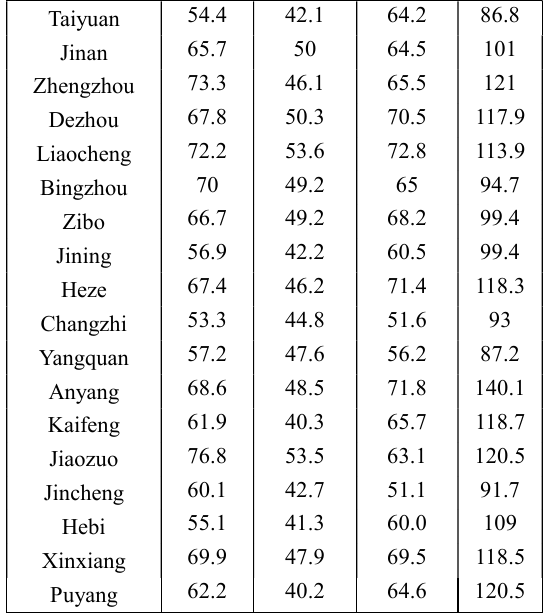
Table 1. Seasonal variation of PM2.5 concentration in various